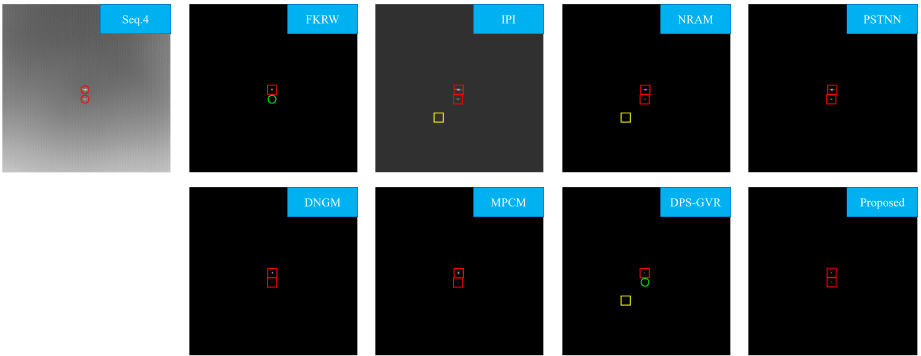
Figure 9. Original images and enhanced images by the different methods for Seq.2–Seq.4. The red circles indicate the position of the actual targets. The green circles mark missing detections. The correct and false segmentation results are marked by red and yellow boxes, respectively. Table 4. Average BSF and CG using different methods on four sequences. The best-obtained re- sults are bolded, and the second-best results are underlined.